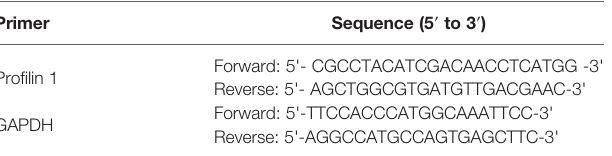
TABLE 2 | Primers for real-time quantitative PCR